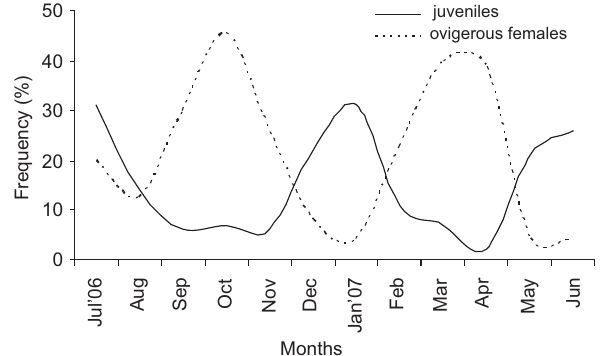
Figure 3. Monthly frequency of ovigerous females and juveniles of U. rapax from Itaipu Lagoon.